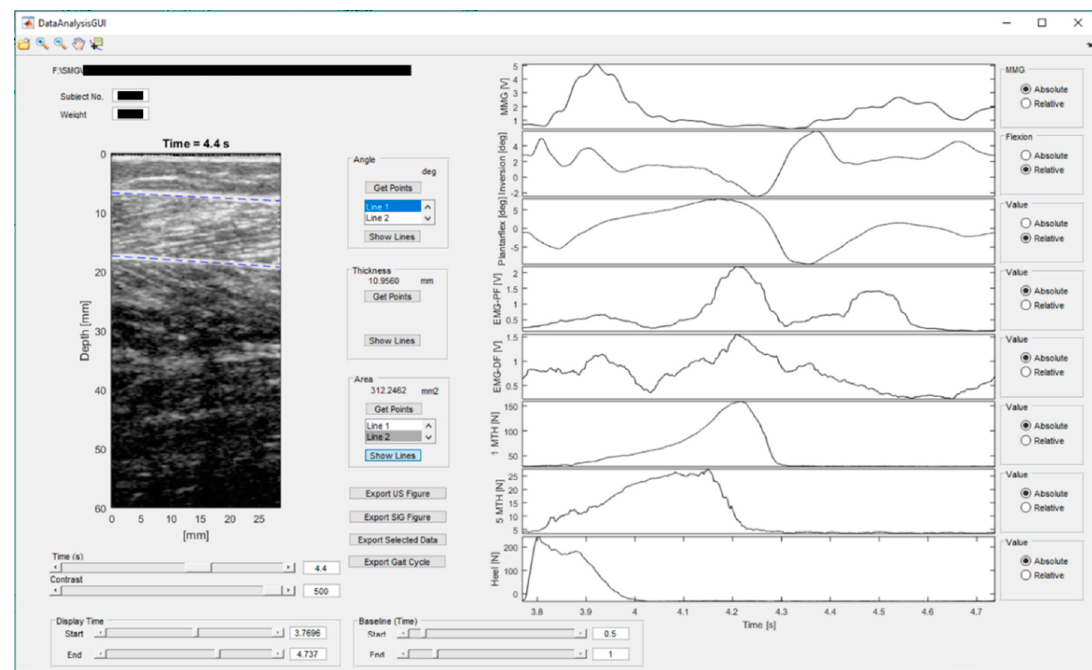
Figure 3. An example of user-interface (UI) of the mobiles SMG system.